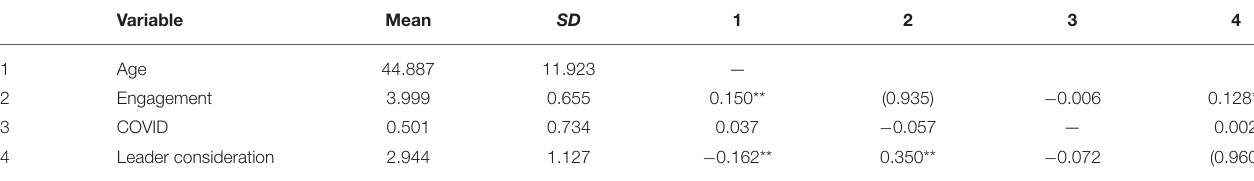
TABLE 1 | Means, standard deviations, reliabilities, and correlations of study variables.